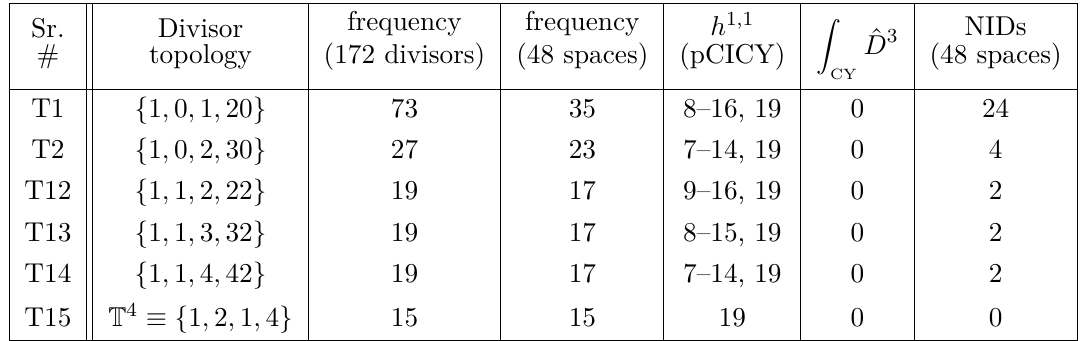
Table 14 . Divisor topologies for non-favorable pCICYs and their frequencies of appearance. Here the Hodge numbers are collected as { h 0 , 0 , h 1 , 0 , h 2 , 0 , h 11 }